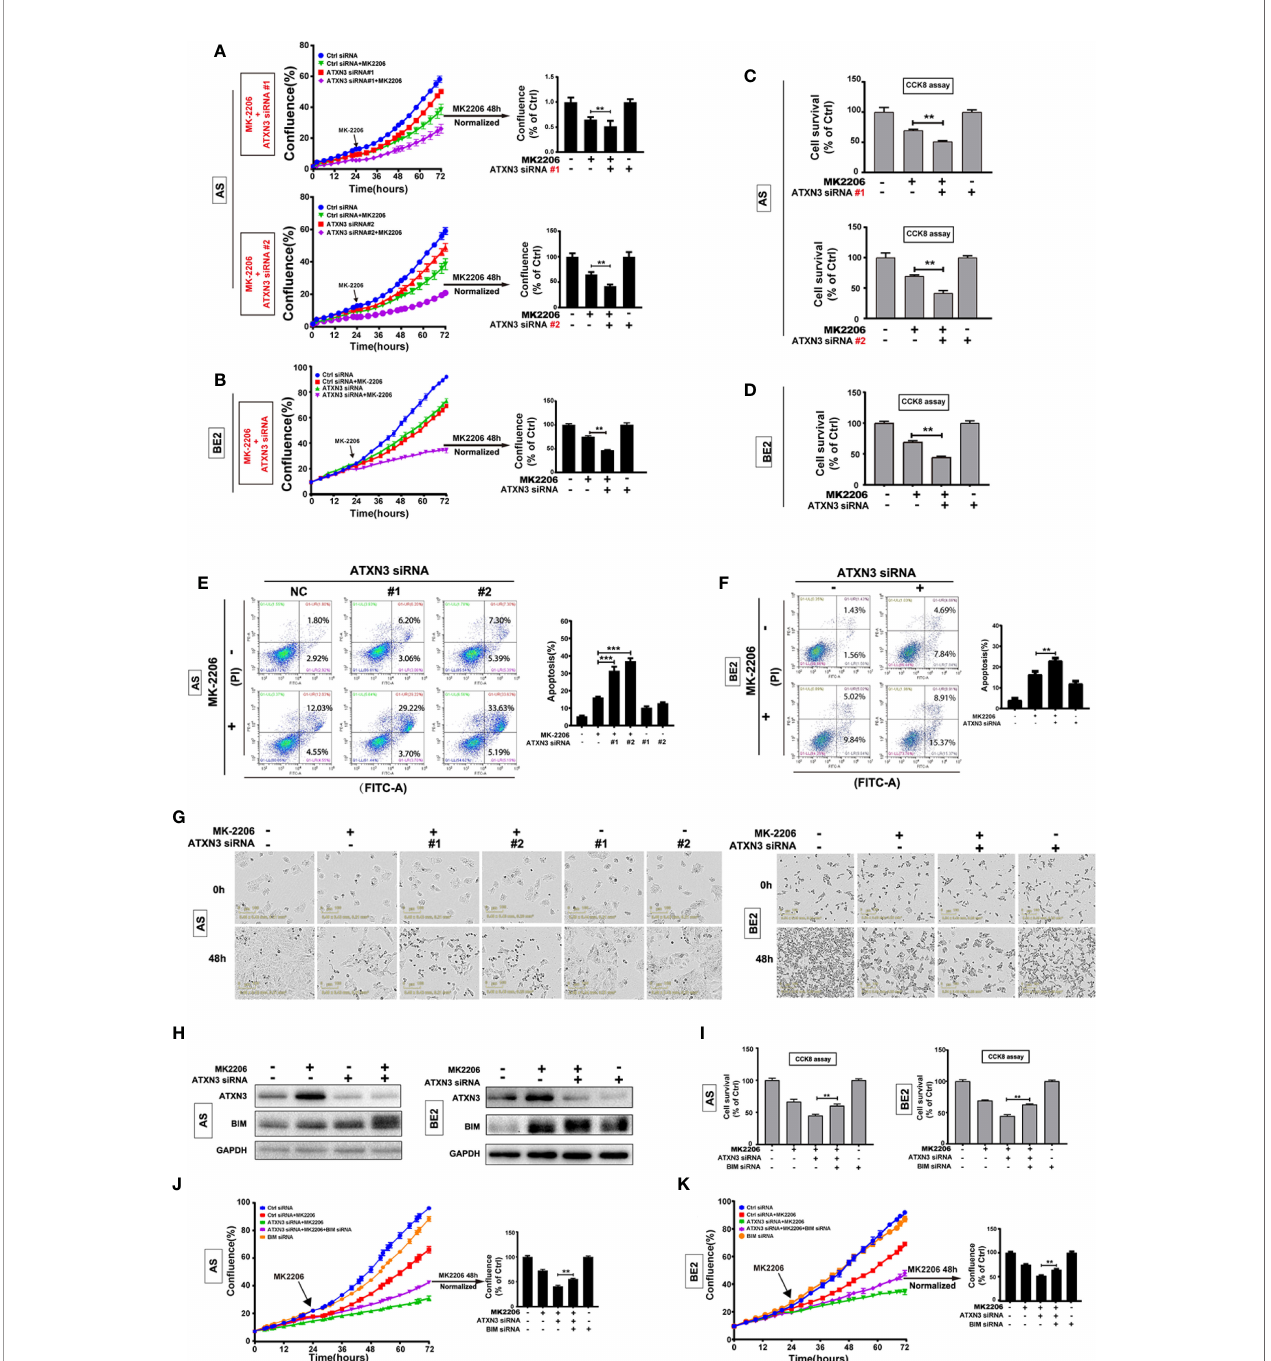
FIGURE 3 | BIM mediated the cell death induced by a combination of MK-2206 treatment and ATXN3 downregulation in NB cells. AS cells were transfected with ATXN3 siRNAs (#1 and #2) and BE2 cells were transfected with ATXN3 siRNA #2 (marked as ATXN3 siRNA) for 16 h followed by 48 h treatment of MK-2206. (A, B) Cell con fl uence was dynamically detected by IncuCyte Zoom and analyzed at the end of experiment; (C, D) Cell survival was detected by CCK8 assay; (E, F) Cell apoptosis was detected by Annexin V/PI fl ow cytometry. Bar, SD, **, P< 0.01, ***, P<0.001, ATXN3 siRNAs + perifosine vs. control siRNA + perifosine; (G) The images of AS and BE2 cells with ATXN3 siRNAs transfection and perifosine treatment at 0 and 48 h were recorded; (H) AS and BE2 cells were transfected with ATXN3 siRNA2 (marked as ATXN3 siRNA) for 16 h, and treated with MK-2206 for 24 h, the expression of ATXN3 and BIM was detected by Western blot; (I) BIM siRNA #1 (marked as BIM siRNA) and ATXN3 siRNA #2 (marked as ATXN3 siRNA) were transfected into AS and BE2 cells alone or combination, then the cells were treated with MK-2206 for 48 h, cell survival was detected by CCK8 assay; (J, K) Cell con fl uence was detected by IncuCyte Zoom. Bar, SD, **, P<0.01, ATXN3 siRNA + MK-2206 + BIM siRNA vs. ATXN3 siRNA + MK-2206.